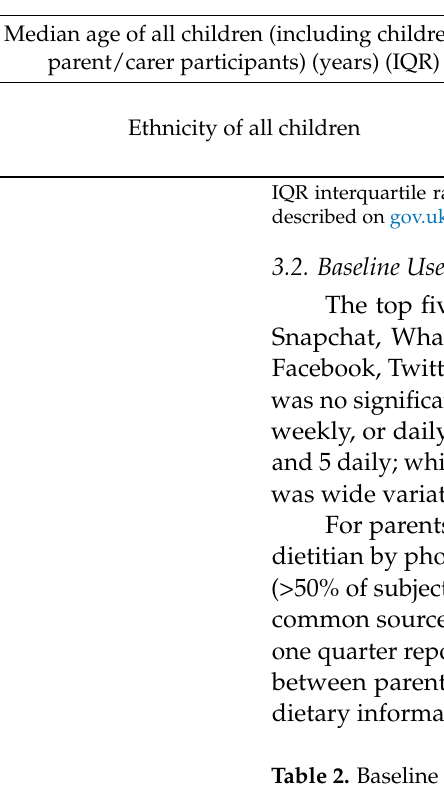
Table 2. Baseline use of apps and dietary